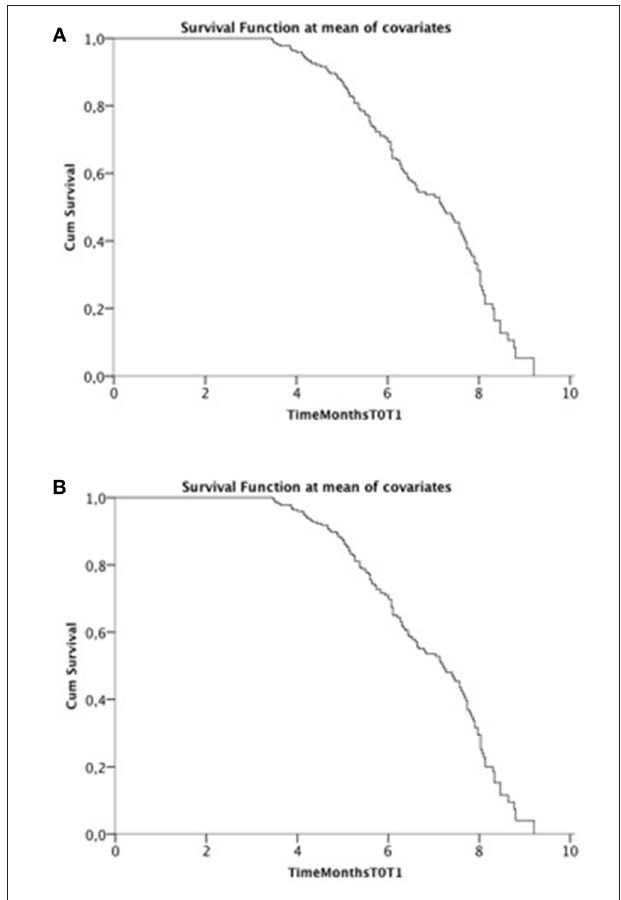
FIGURE 1 | Cox adjusted plot. (A) SVC decay; (B) FVC